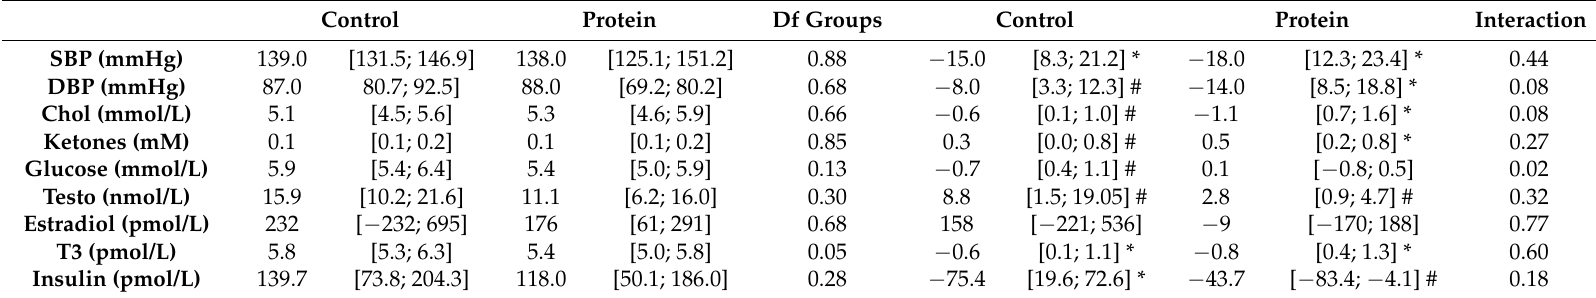
Table 3. Blood parameters and blood